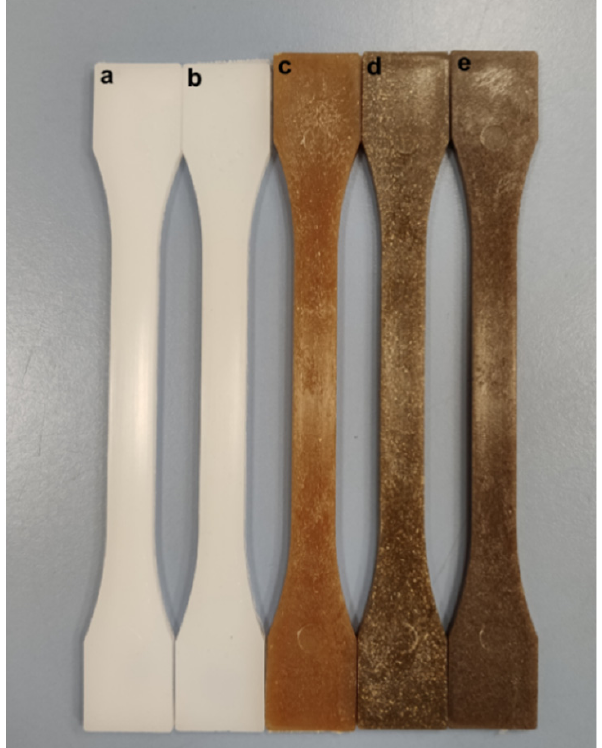
Figure 8. Visual appearance of the samples: ( a ) BioHDPE; ( b ) BioHDPE/PE-g-MA; ( c ) BioHDPE/Hemp/PE-g-MA; ( d ) BioHDPE/Flax/PE-g-MA; ( e ) BioHDPE/Jute/PE-g-MA.